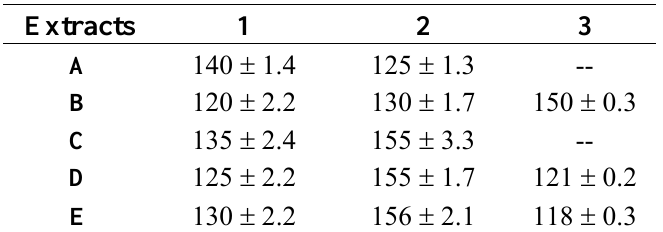
Table 4. Contents in μ g/100 mg of extract A - E (mean ± S.D.) of the flavonoids ( 1 - 3 ) employing the HPLC method.